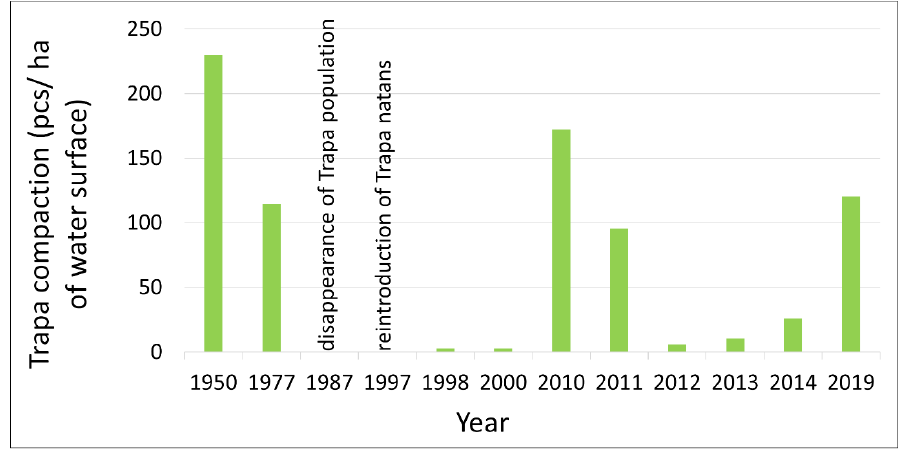
Figure 6. Changes in the density of T. natans in Szumirad reservoir.